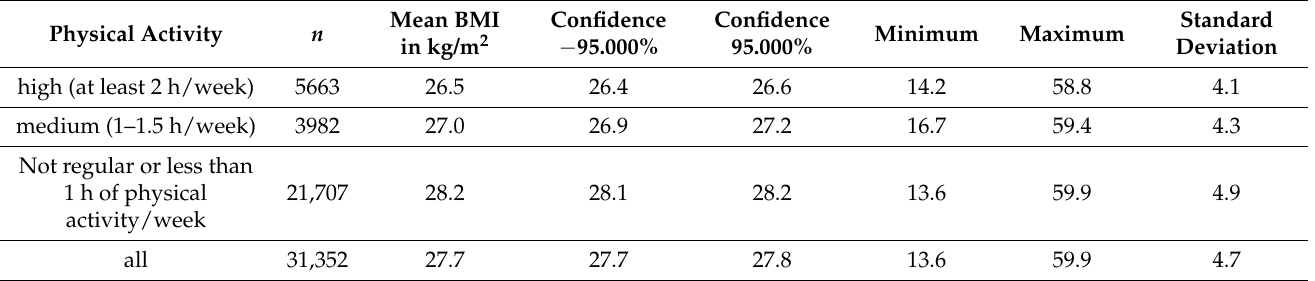
Table 5. Physical activity and BMI (women).